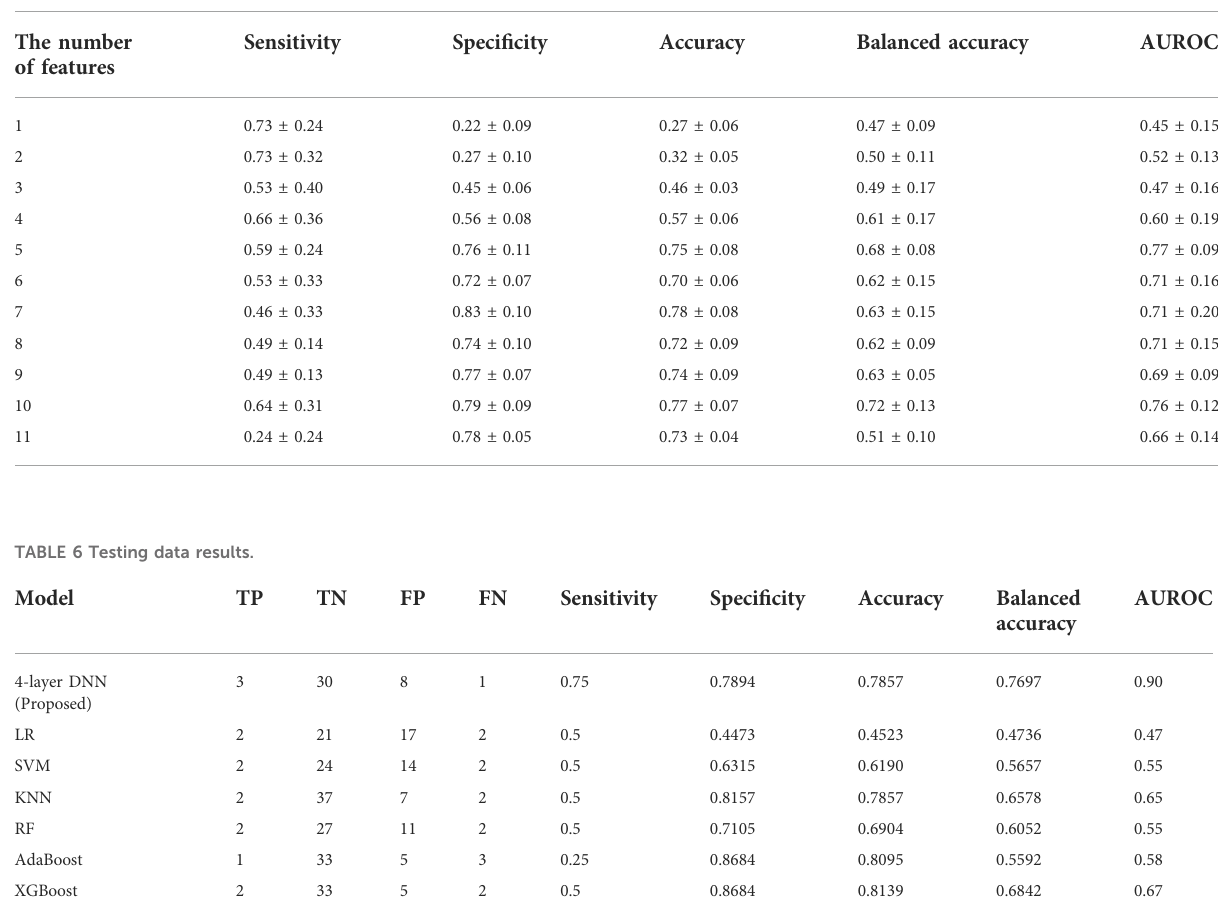
TABLE 5 Cross-validation results from DNN according to the number of top features (mean ± standard deviation). Cross-validation results ( n = 34)